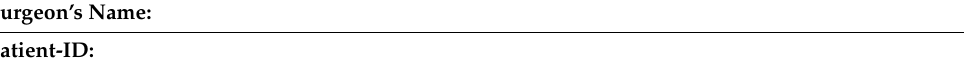
Table 1. Questionnaire regarding the anatomical structure detection as well as the recommended surgical strategy for patients with anterior communicating artery aneurysms, using conventional computed tomography angiography (CTA) images and three-dimensional virtual reality